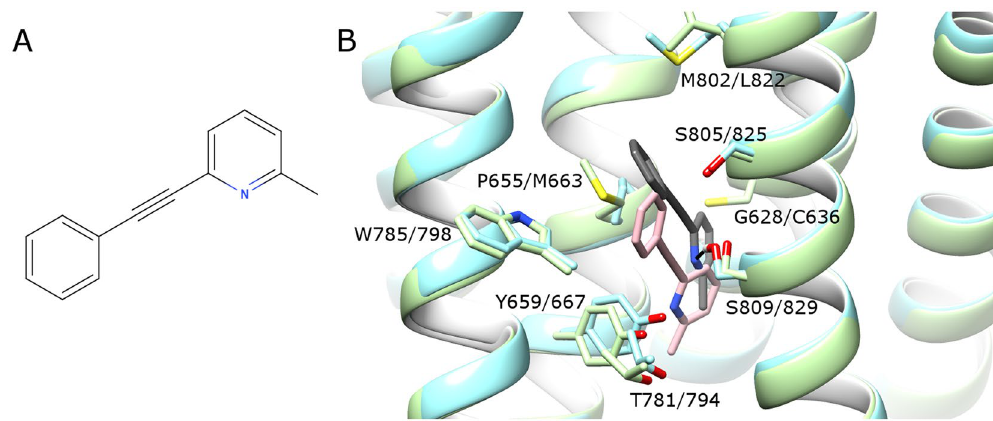
Figure 4. ( A ) 2-Methyl-6-(phenylethynyl)pyridine (MPEP), ( B ) comparison of MPEP (grey) docking in mGlu5 (light blue), and MPEP (pink) docking in mGlu4 (light green) prior to MD simulations. Selected residues delineating allosteric pockets or participating in ligand binding are labelled (labelling: mGlu5 first, mGlu4 second). Protein-ligand H-bonds are represented by black lines. Helix orientations as follows: TM5 left, TM3 centre-left, TM7 centre-right, TM1 right. TM6 backbone is